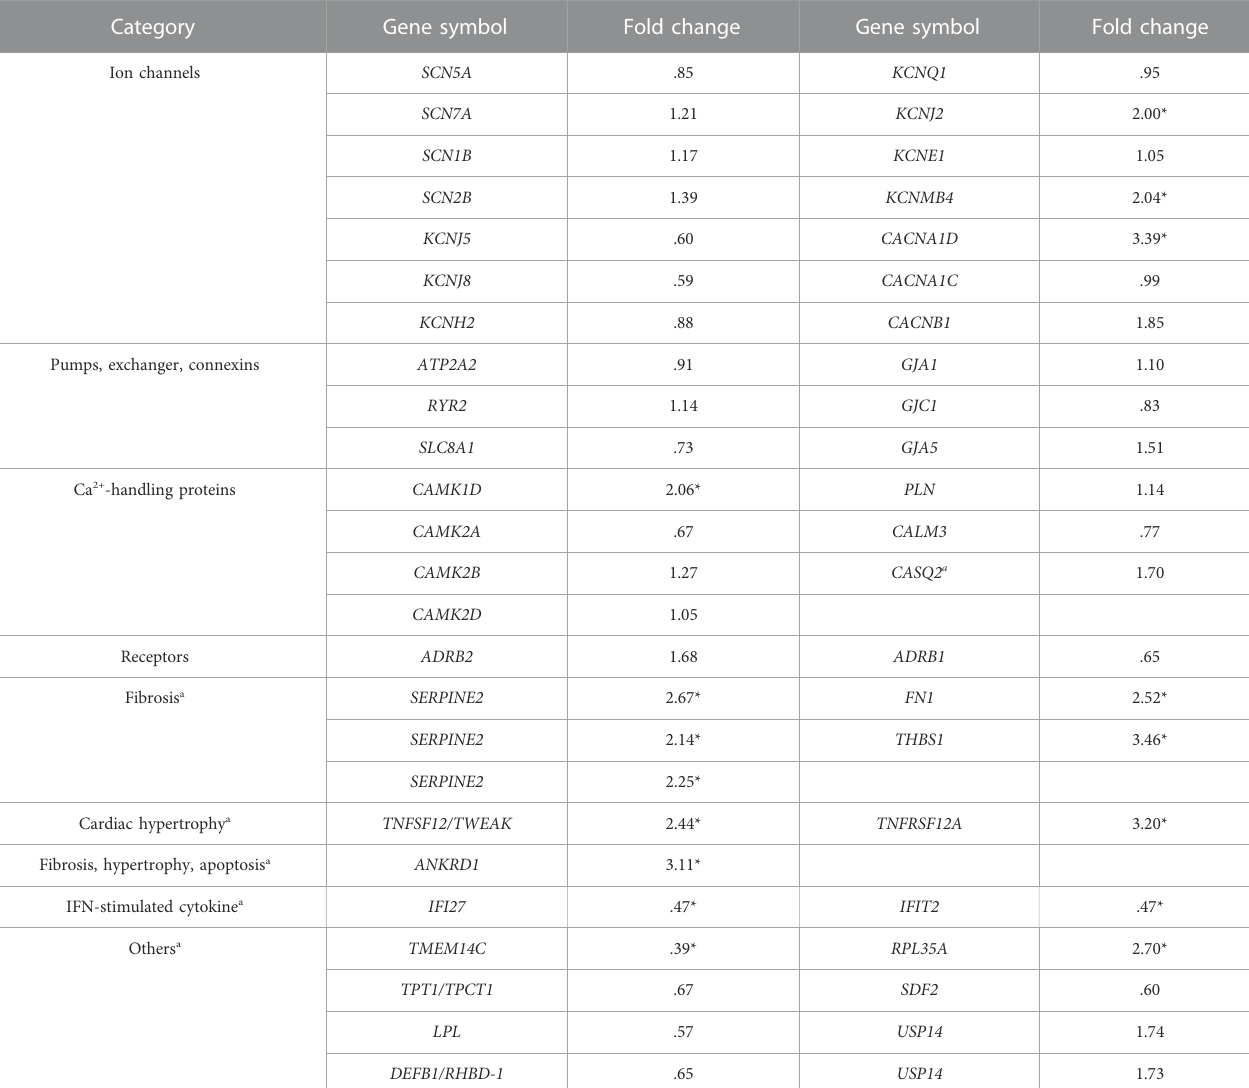
TABLE 4 Fold changes in expression levels of genes in the chronic atrioventricular block monkeys ( n = 2) in comparison to intact ones ( n = 4).